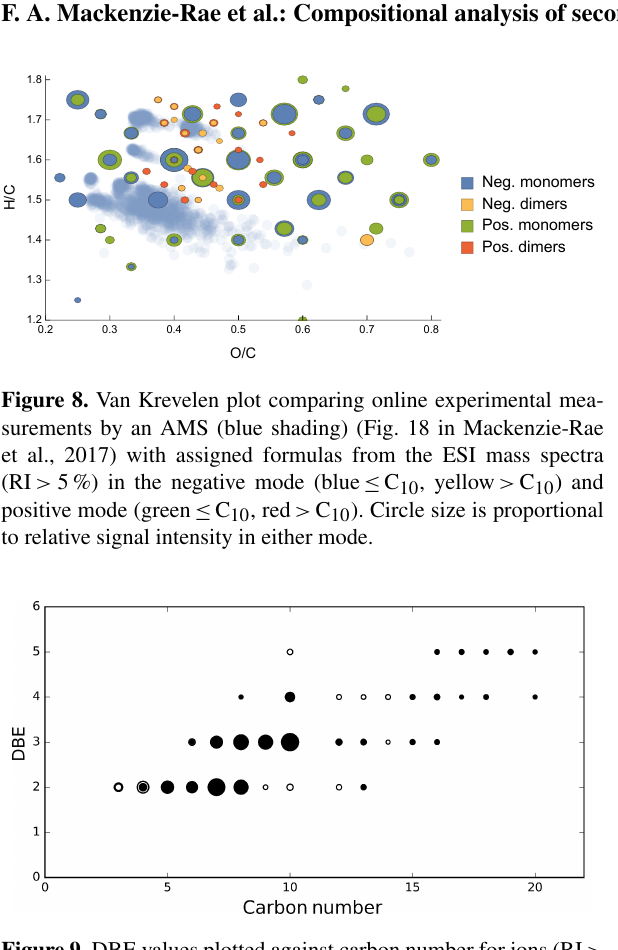
Figure 9. DBE values plotted against carbon number for ions (RI > 5%) detected in the positive (open circle) and negative (closed cir- cle) ionisation mode spectra from experiment 10. The size of data points is proportional to signal